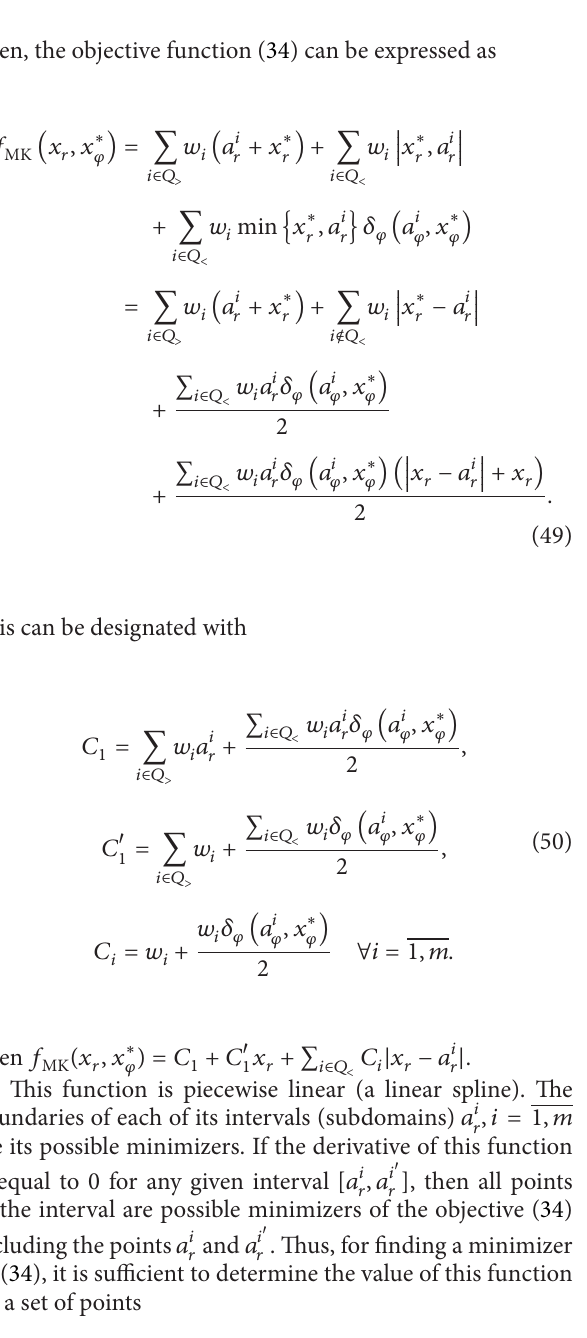
Algorithm 8 is proposed for solving the minimization problem with the objective function (32)–(34).